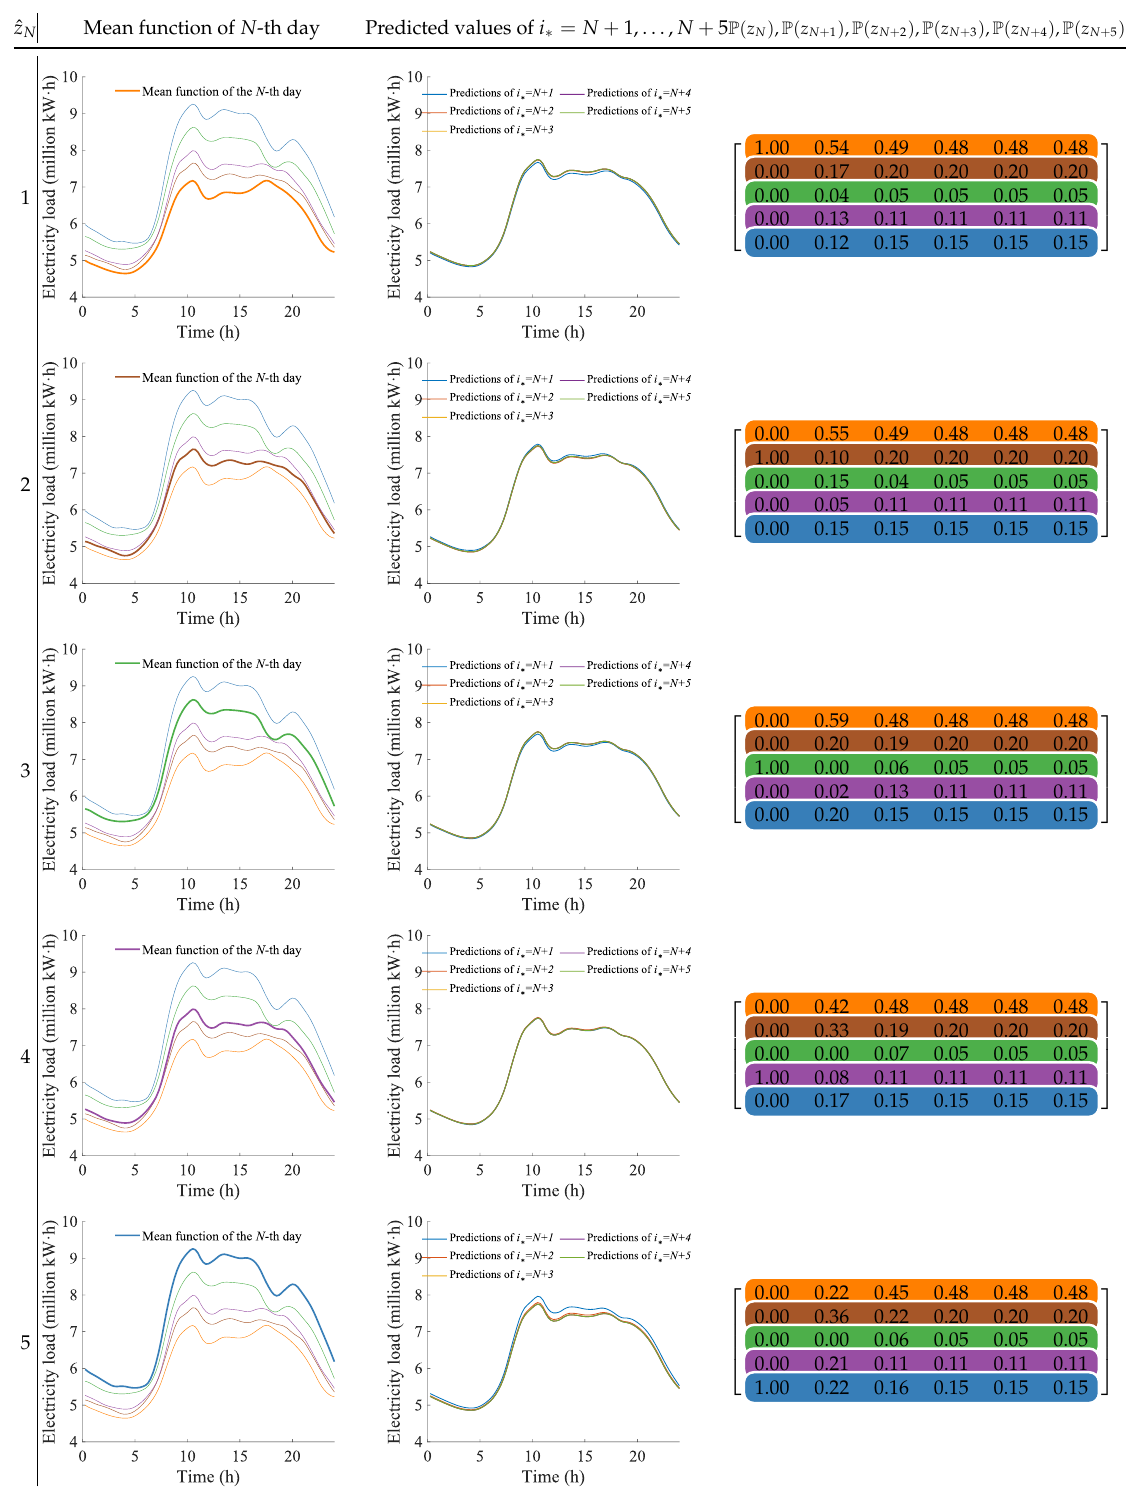
Figure 7. Estimated values ˆ y ˆ z = k , where k =